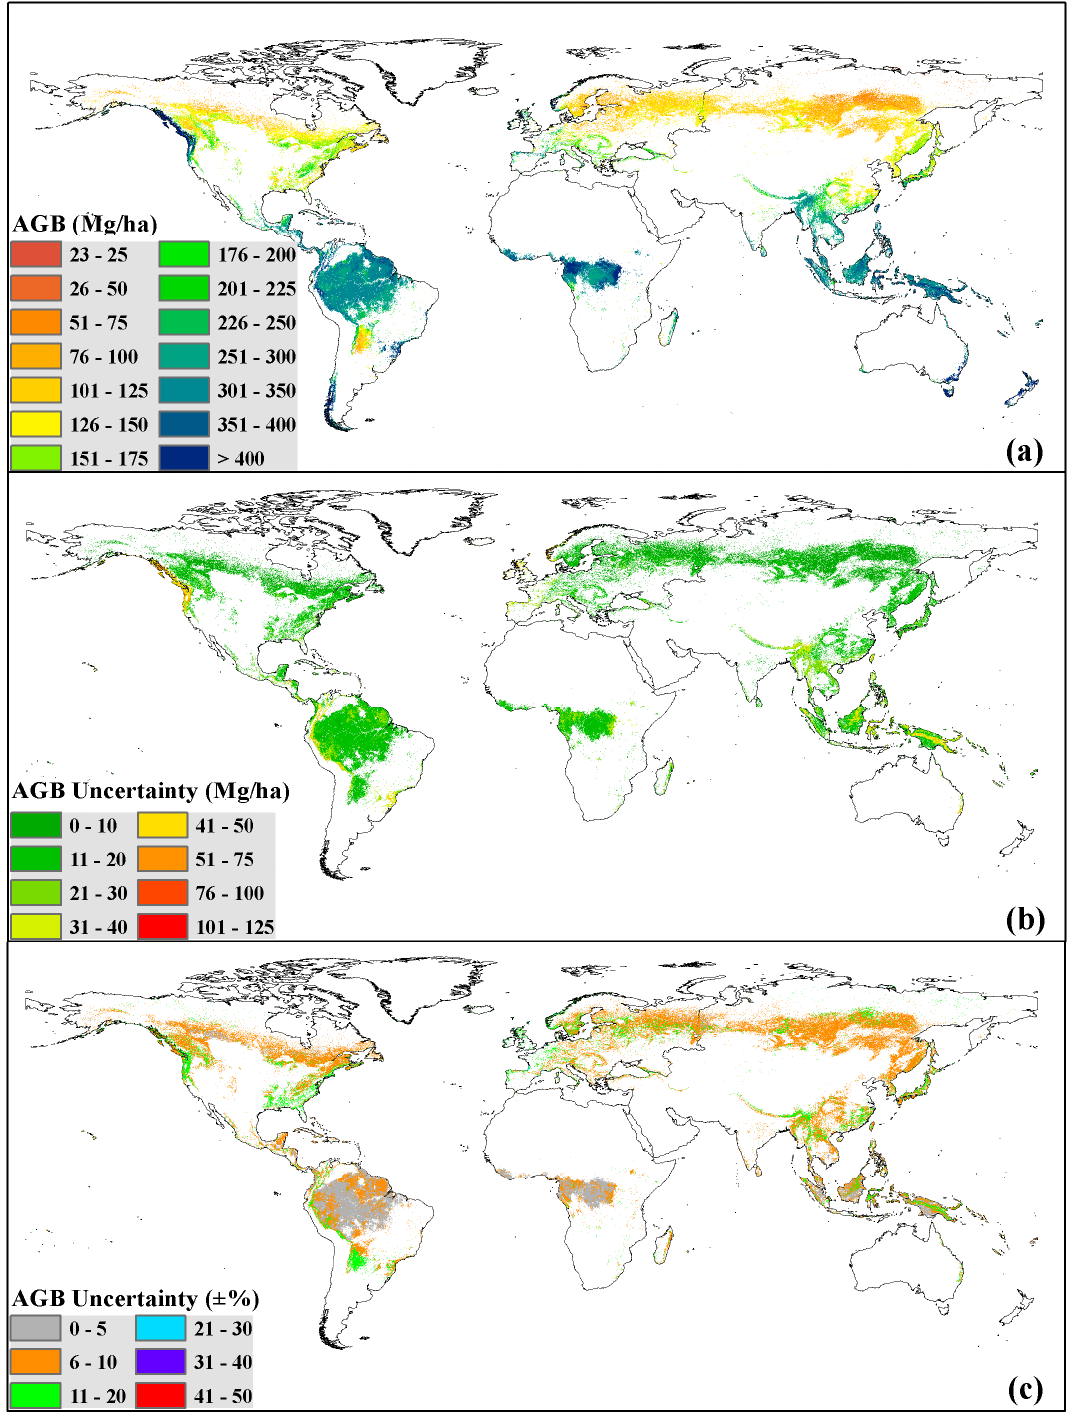
Figure 4. ( a ) The derived wall-to-wall map of global forest AGB in this study; ( b ) the absolute uncertainty induced by plot location uncertainty (estimated as the standard deviation of the 100 RF run results); and ( c ) the relative uncertainty induced by plot location uncertainty. The study region was bounded at 80° north latitude and 58° south latitude and from longitude − 180° to 180°. The subtropical dry forests (Mediterranean) were mainly distributed in Southern Europe (193.62 ± 51.85 Mg/ha) with a few areas in North America, South America (333.72 ± 55.95 Mg/ha), Asia (157.96 ± 19.91 Mg/ha), and Africa (242.90 ± 89.24 Mg/ha). Subtropical humid forests were mainly distributed in Asia, southern North America, and South America. The subtropical humid forest in South America had the highest AGB density (336.65 Mg/ha) and variation (101.15 Mg/ha) compared with those in